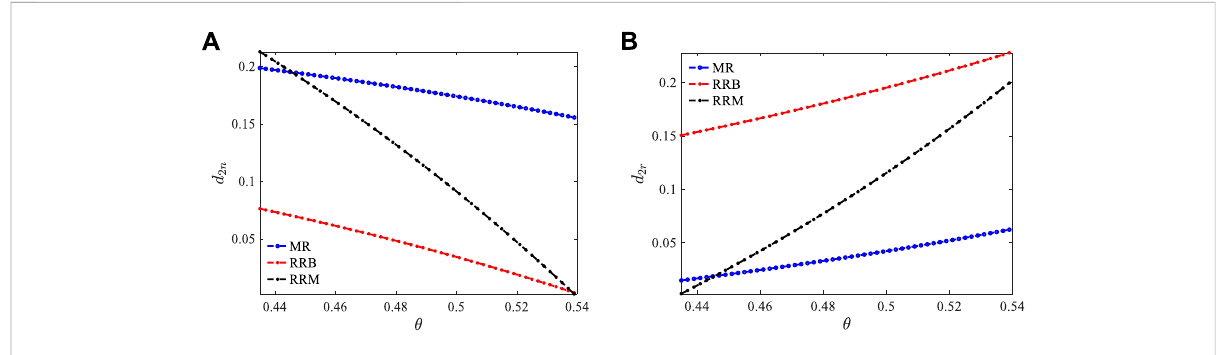
FIGURE 4 Impact of consumer preference rate for remanufactured products on demand. (A) Impact of preference rates on demand for new products in the second period. (B) Impact of preference rates on demand for remanufactured products in the second